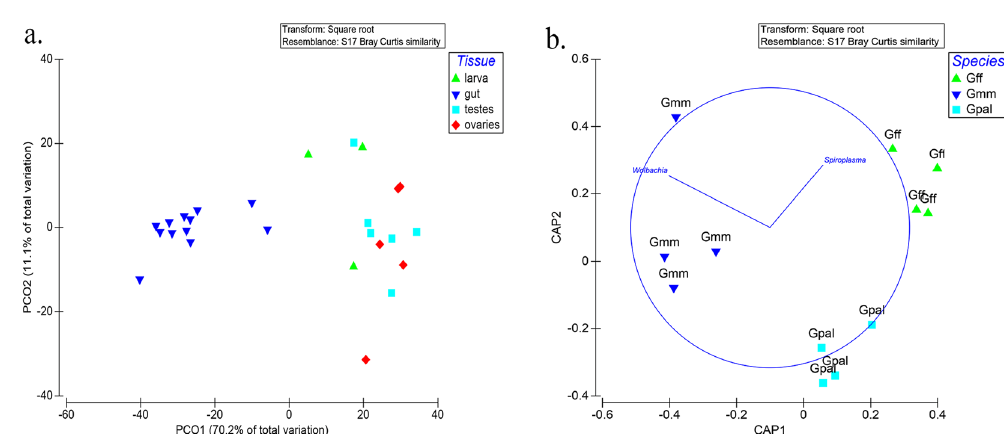
Figure 3. ( a ) Principal coordinate analysis (PC οΑ ) of bacterial communities based on relative abundances of OTUs with ordinations from laboratory populations of gut, ovaries, testes and larvae. Variance explained by each PC οΑ axis is given in parentheses. ( b ) Canonical analysis of principal coordinates (CAP) ordinations of gonadal bacterial communities based on relative abundances of OTUs from the laboratory populations. The constrained ordinations show maximized differences among the different Glossina species, (Gmm: Glossina morsitans morsitans , Gff: Glossina fuscipes fuscipes , Gpal: Glossina pallidipes ). (trace Q_m’HQ_m (0.9598; p <